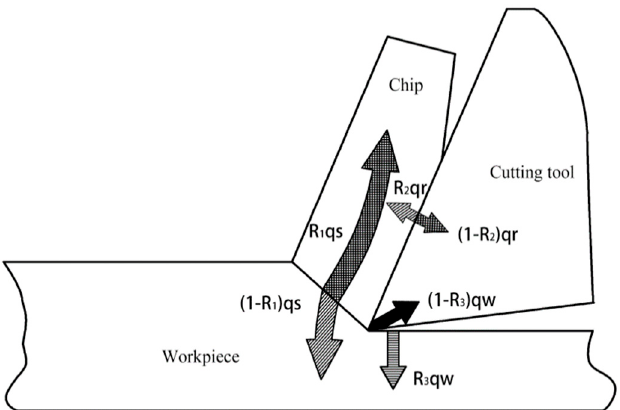
Figure 6. Generation and conduction of heat during cutting.